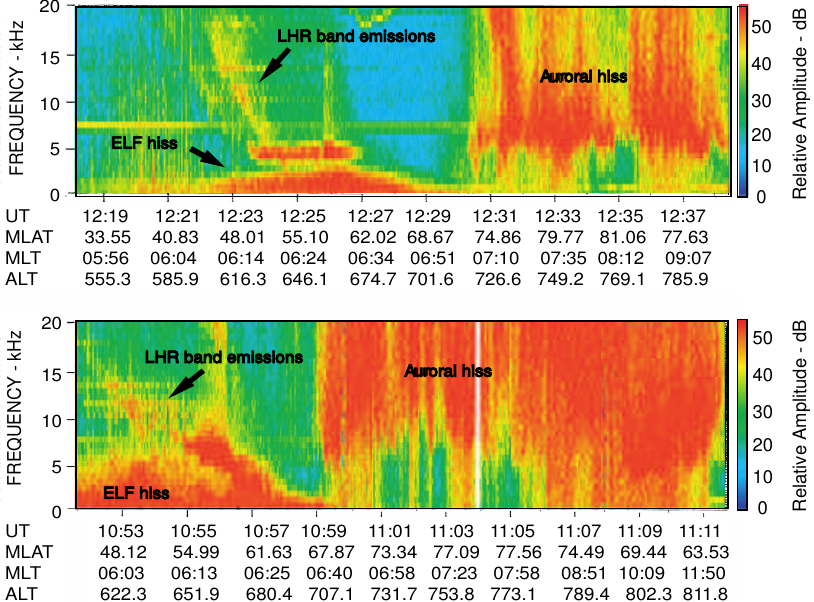
Fig. 1. Dynamic spectra of electric field observed in middle and auroral latitudes on two successive days on 17 and 18 October 1984.